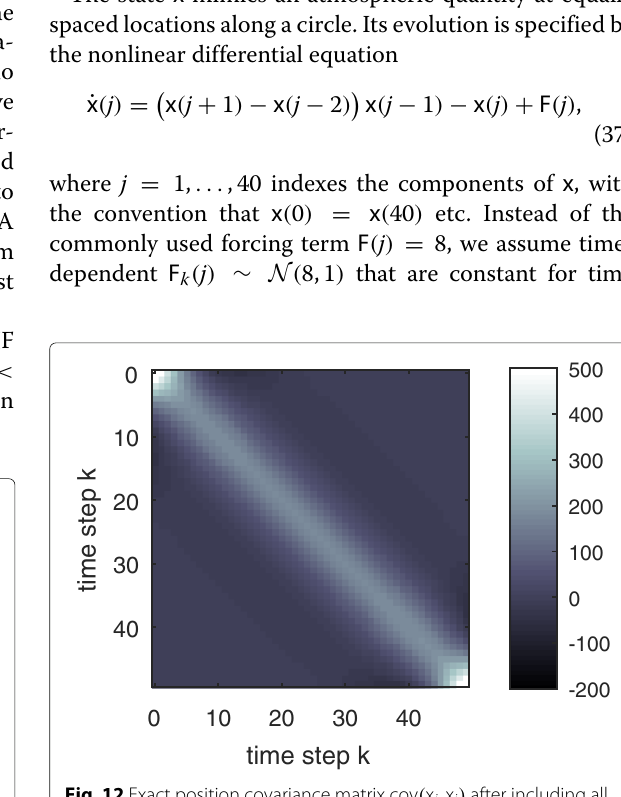
Fig. 12 Exact position covariance matrix cov ( x i ,x j ) after including all